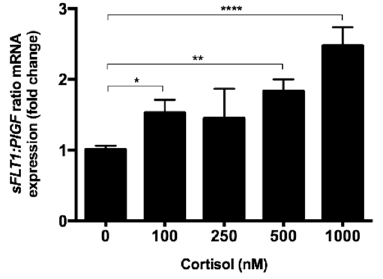
Figure A2. RT-qPCR of sFLT:PlGF ratio. sFLT1:PlGF mRNA ratio in SGHPL-4 cells treated with continuous exposure to cortisol (100, 250, 500, 1000 nM) and vehicle (0 nM) in the medium. Data were compared by Mann–Whitney test. Data are presented as mean ± SEM. * p < 0.05; ** p < 0.01; **** p < 0.0001. sFLT1 (soluble VEGFR-1), soluble Vascular endothelial growth factor receptor 1; PlGF, Placental growth factor. Cell treatment was repeated three times.